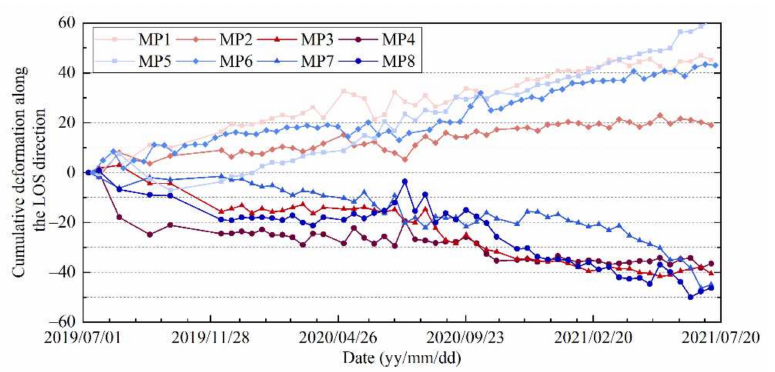
Figure 13. Cumulative deformations along the LOS direction of some